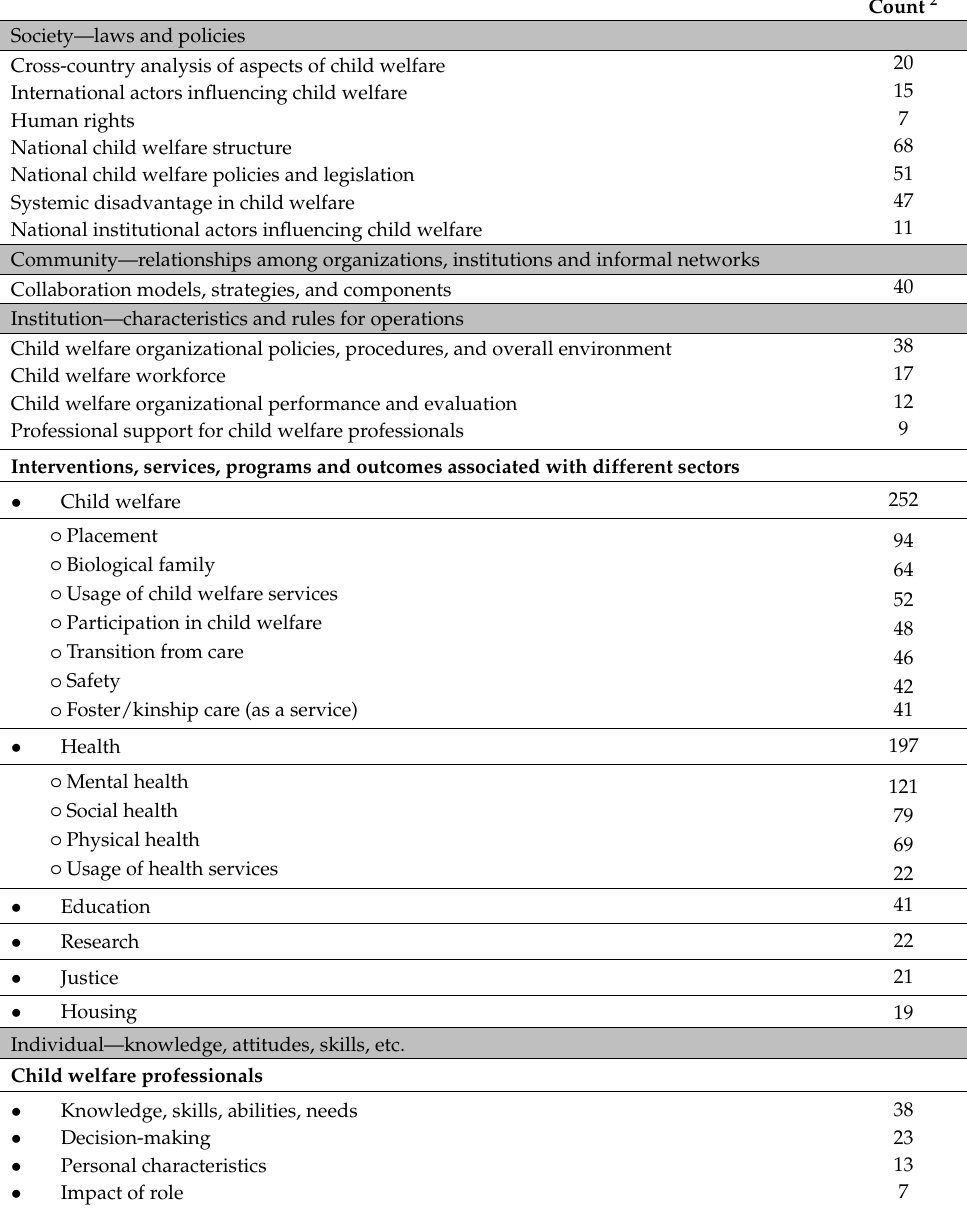
Table 5. Thematic Focus of Included Articles. 1